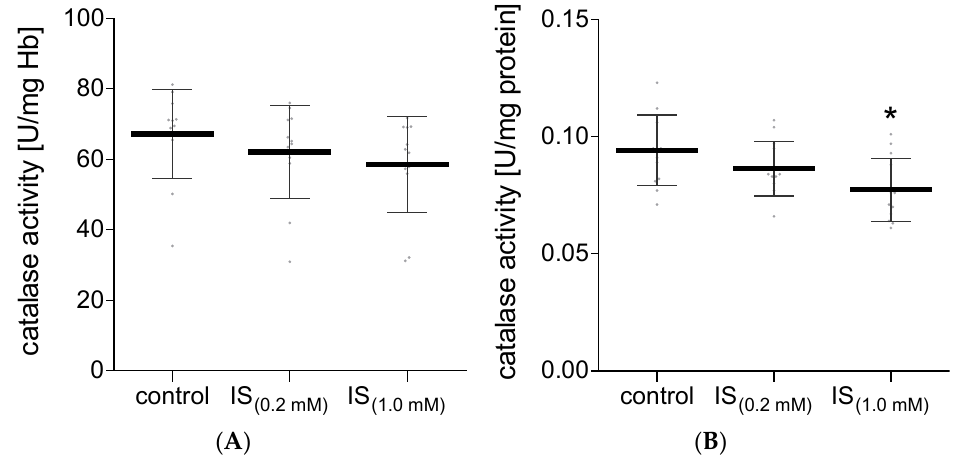
Figure 7. Alterations in the catalase activity in hemolysate ( A ) and plasma ( B ) after incubation with IS. Data are expressed as mean ± standard deviation, n = 12, * p < 0.05—IS (1.0 mM) vs. control. Gray spots: values of single results.